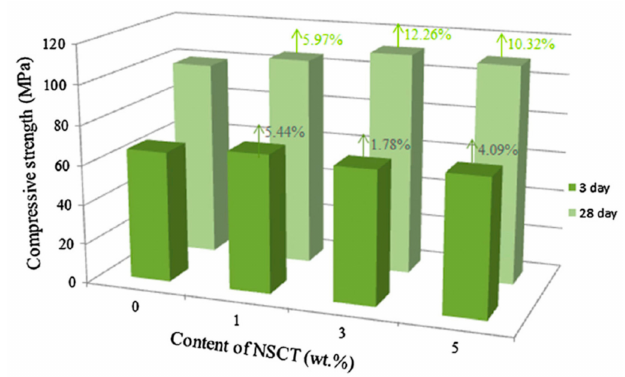
Figure 4. Compressive strength of NSCTRRPC test specimens with di ff erent values of NSCT content at curing age of 3 and 28 days. Reprinted with permission from [80]. Copyright © 2017, Elsevier